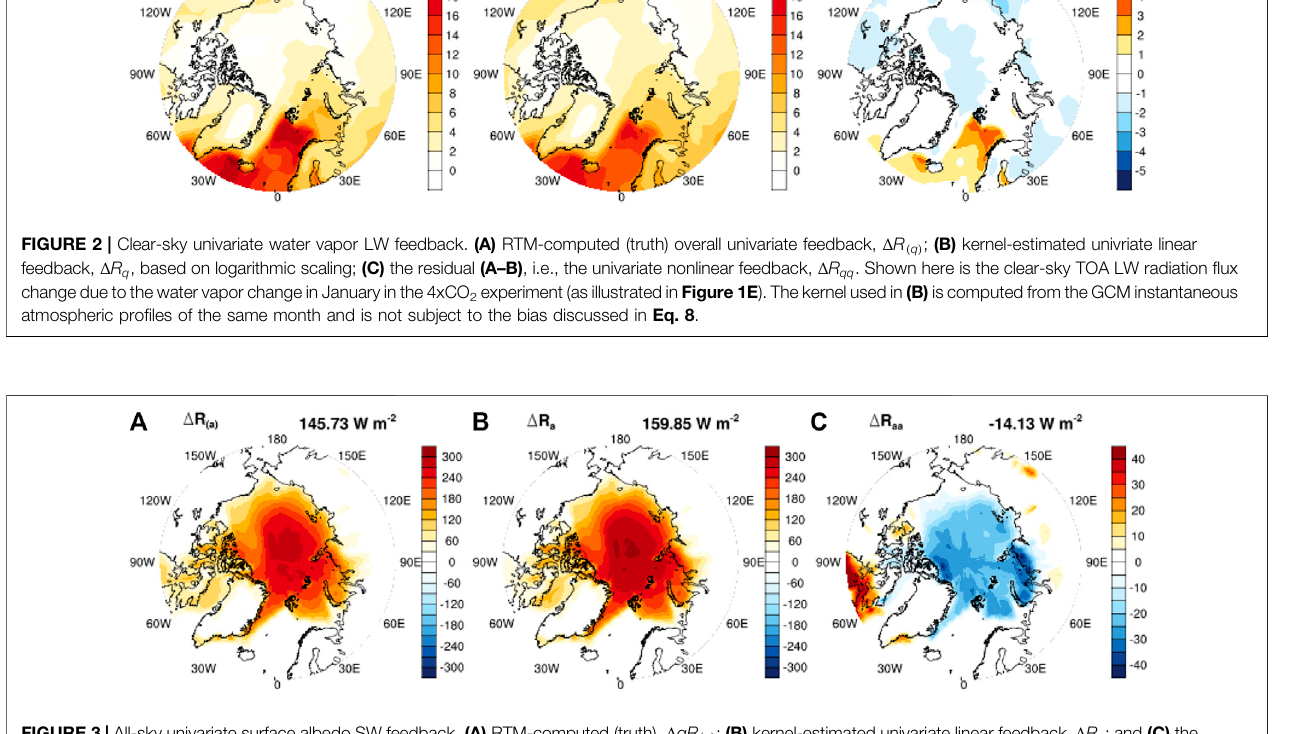
FIGURE 3 | All-sky univariate surface albedo SW feedback. (A) RTM-computed (truth), Δ qR ( a ) ; (B) kernel-estimated univariate linear feedback, Δ R a ; and (C) the residual (A – B) , i.e., the univariate nonlinear term Δ R aa . Shown here is the all-sky TOA SW radiation fl ux change due to the surface albedo change in June in the 4xCO 2 experiment (as illustrated in Figure 1B